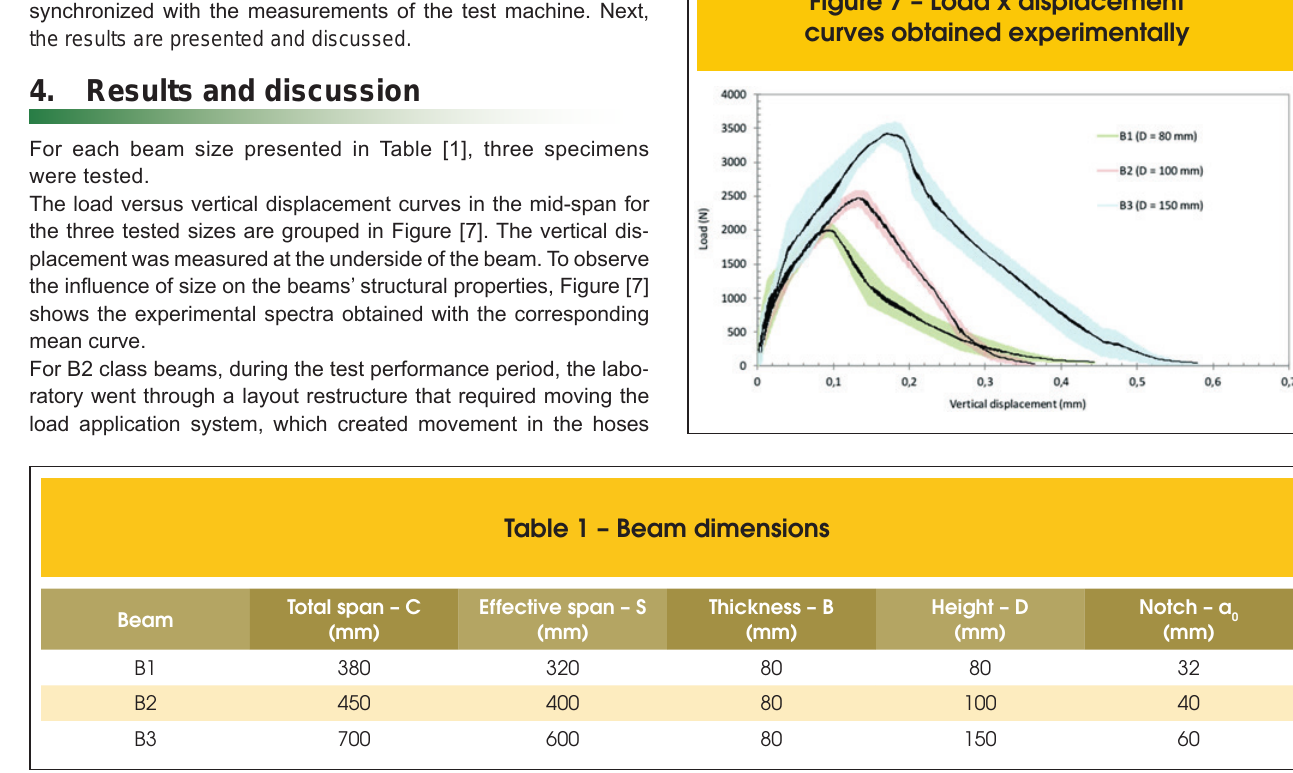
Figure 7 – Load x displacement curves obtained